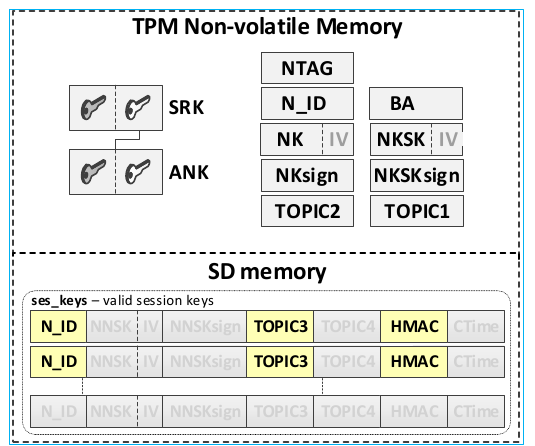
Figure 18. An example of data stored on the N node after the procedure in which two new nodes were added.